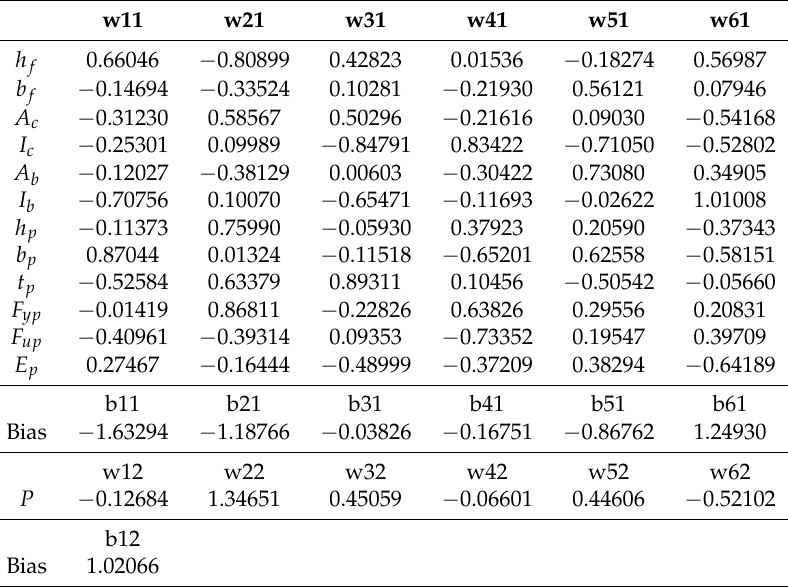
Table A3. Detailed meta-model for strength response of SPSW.